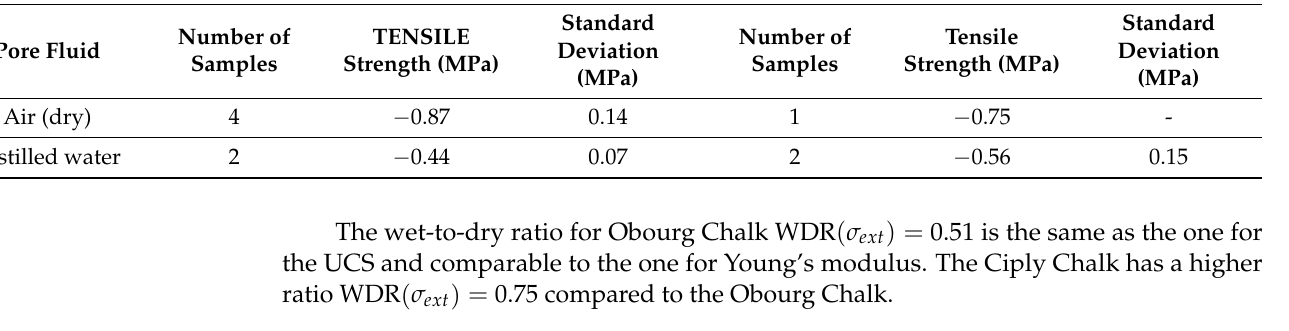
Table 3. Tensile strength values for both chalks for dry and water-saturated samples. Obourg Chalk Ciply